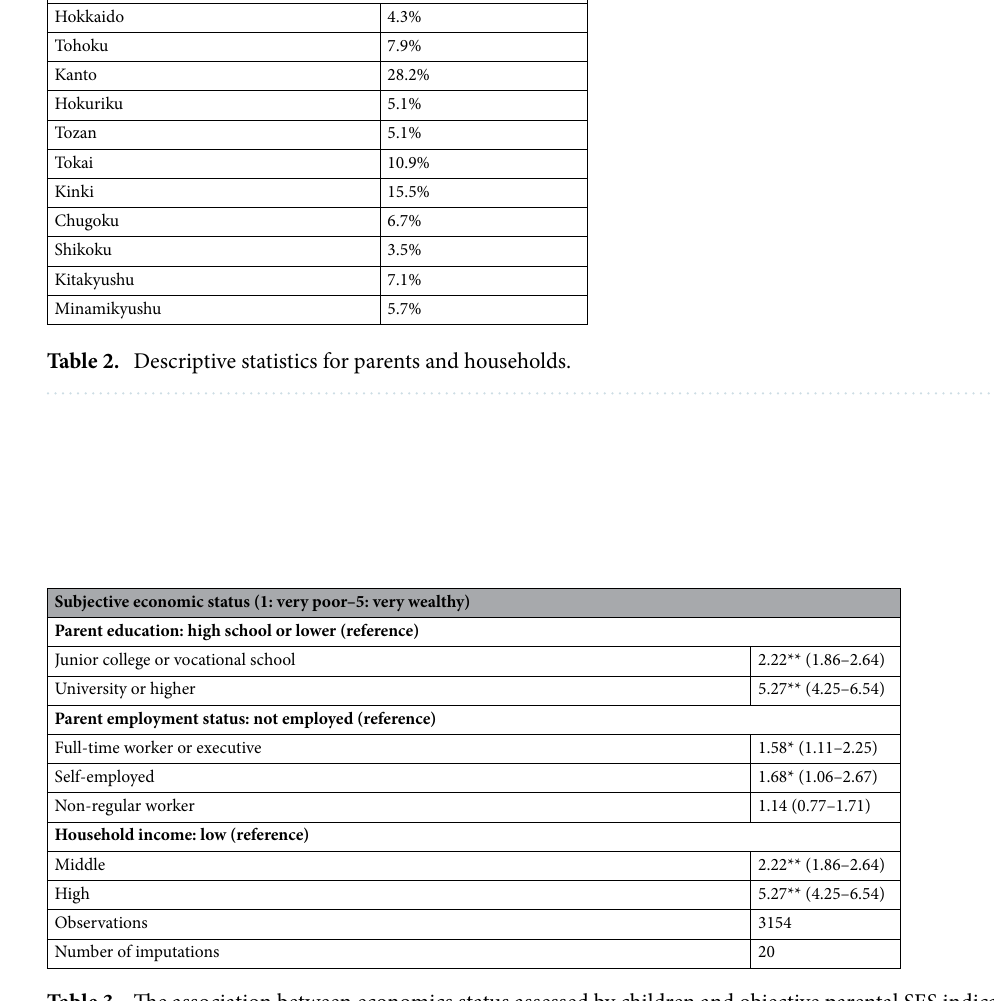
Table 3. The association between economics status assessed by children and objective parental SES indicators. These results were estimates by multilevel ordered logistic regression, controlling for sex of a child, parental ages, being in a single-parent household, and the scale of a residential area and fitting a three-level model incorporating school type nested within residential areas. Values are odds ratios and 95% confidence intervals based on robust standard errors in parenthesis with *p < 0.05, **p <